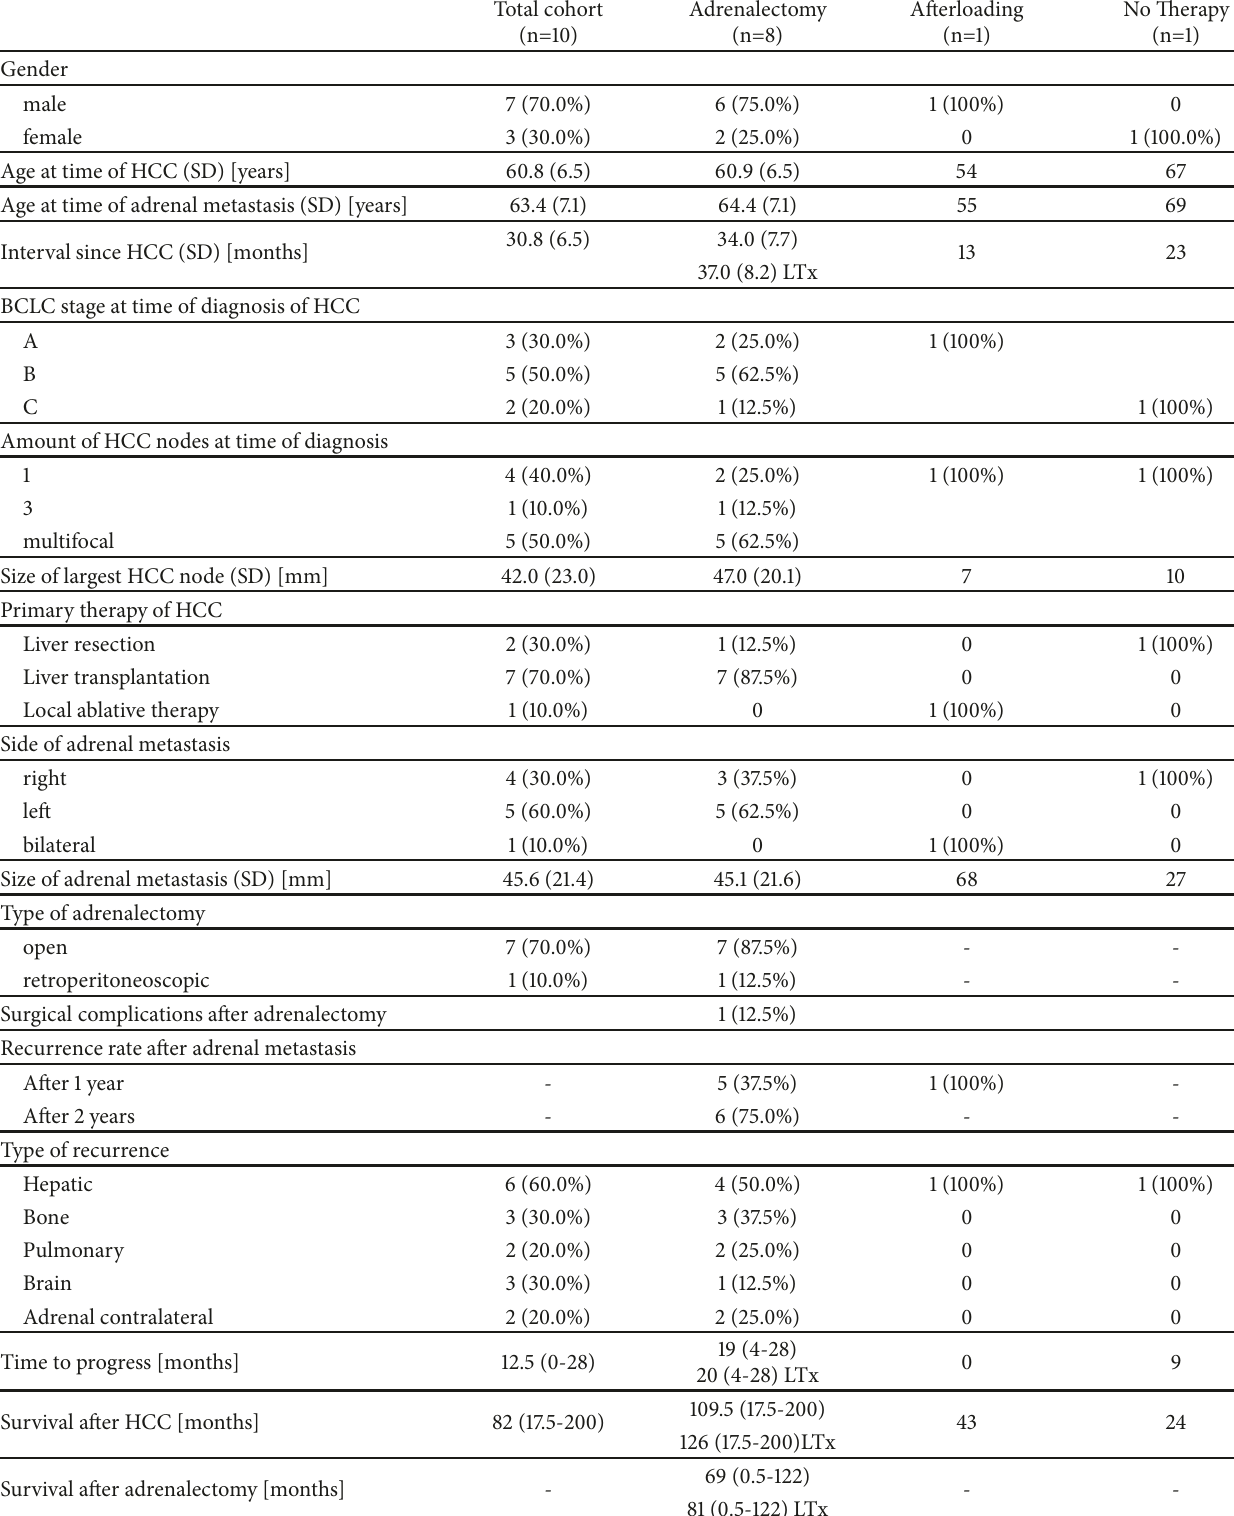
Table 1: Demographic data and survival dates: N=10 (BCLC= Barcelona clinic liver cancer; HCC= hepatocellular carcinoma; SD= standard